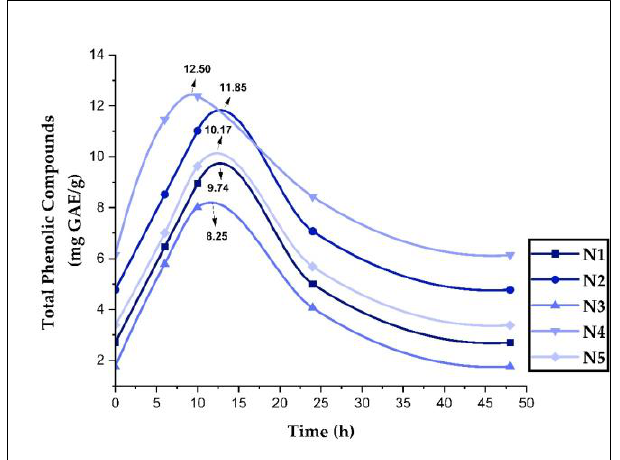
Figure 10. Stability and release of phenolic compounds in aqueous solutions in nanoencapsulates (N1, N2, N3, N4, and N5).